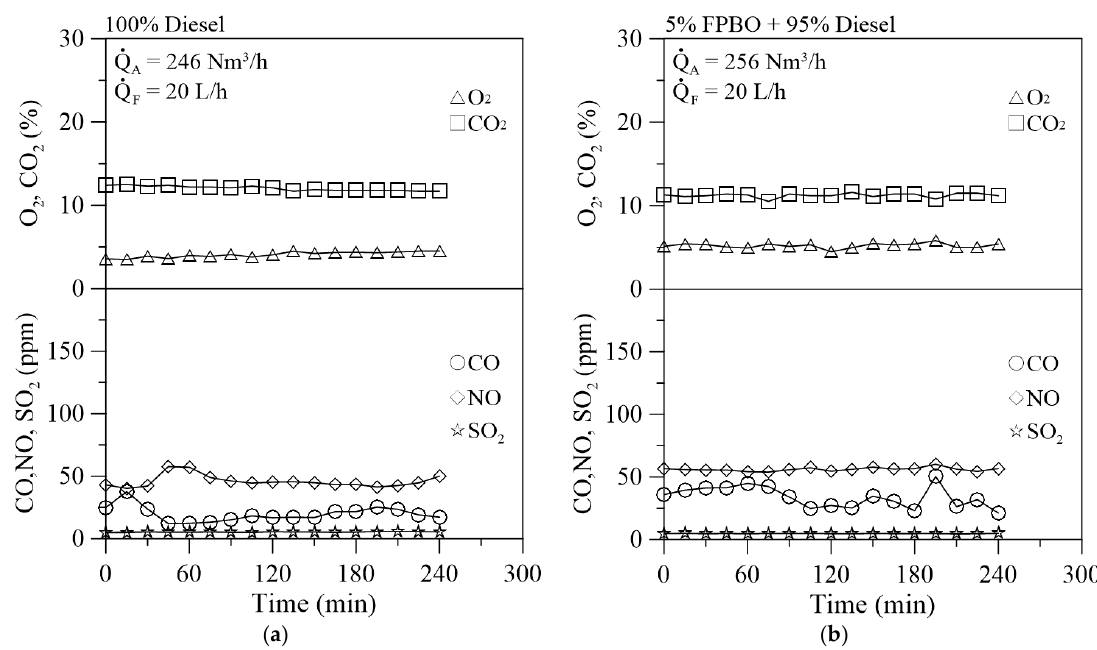
Figure 7. Emissions versus time: ( a ) when burning diesel alone; and ( b ) when burning the blend of 5% FPBO + 95% diesel.